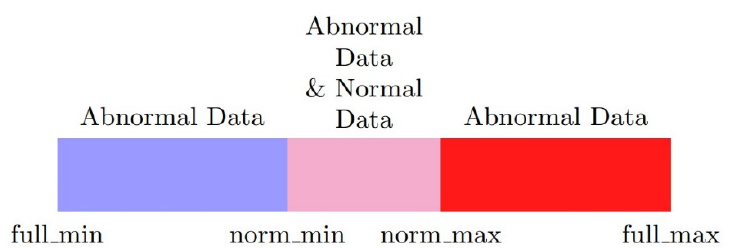
Figure 1. Relationship between parameters and data value fields.